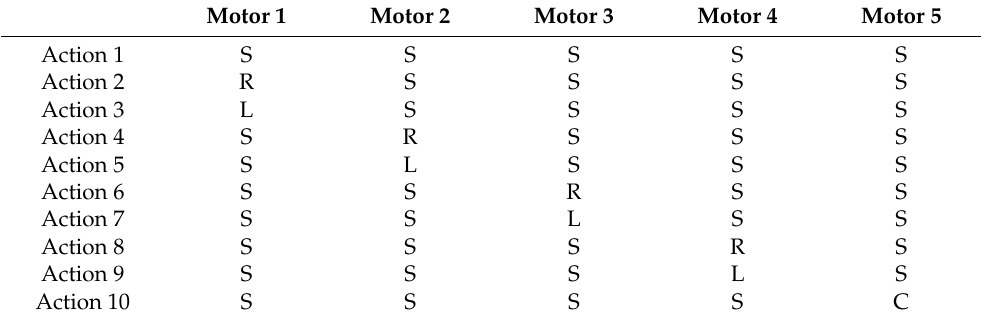
Table 3. Combination of actions.